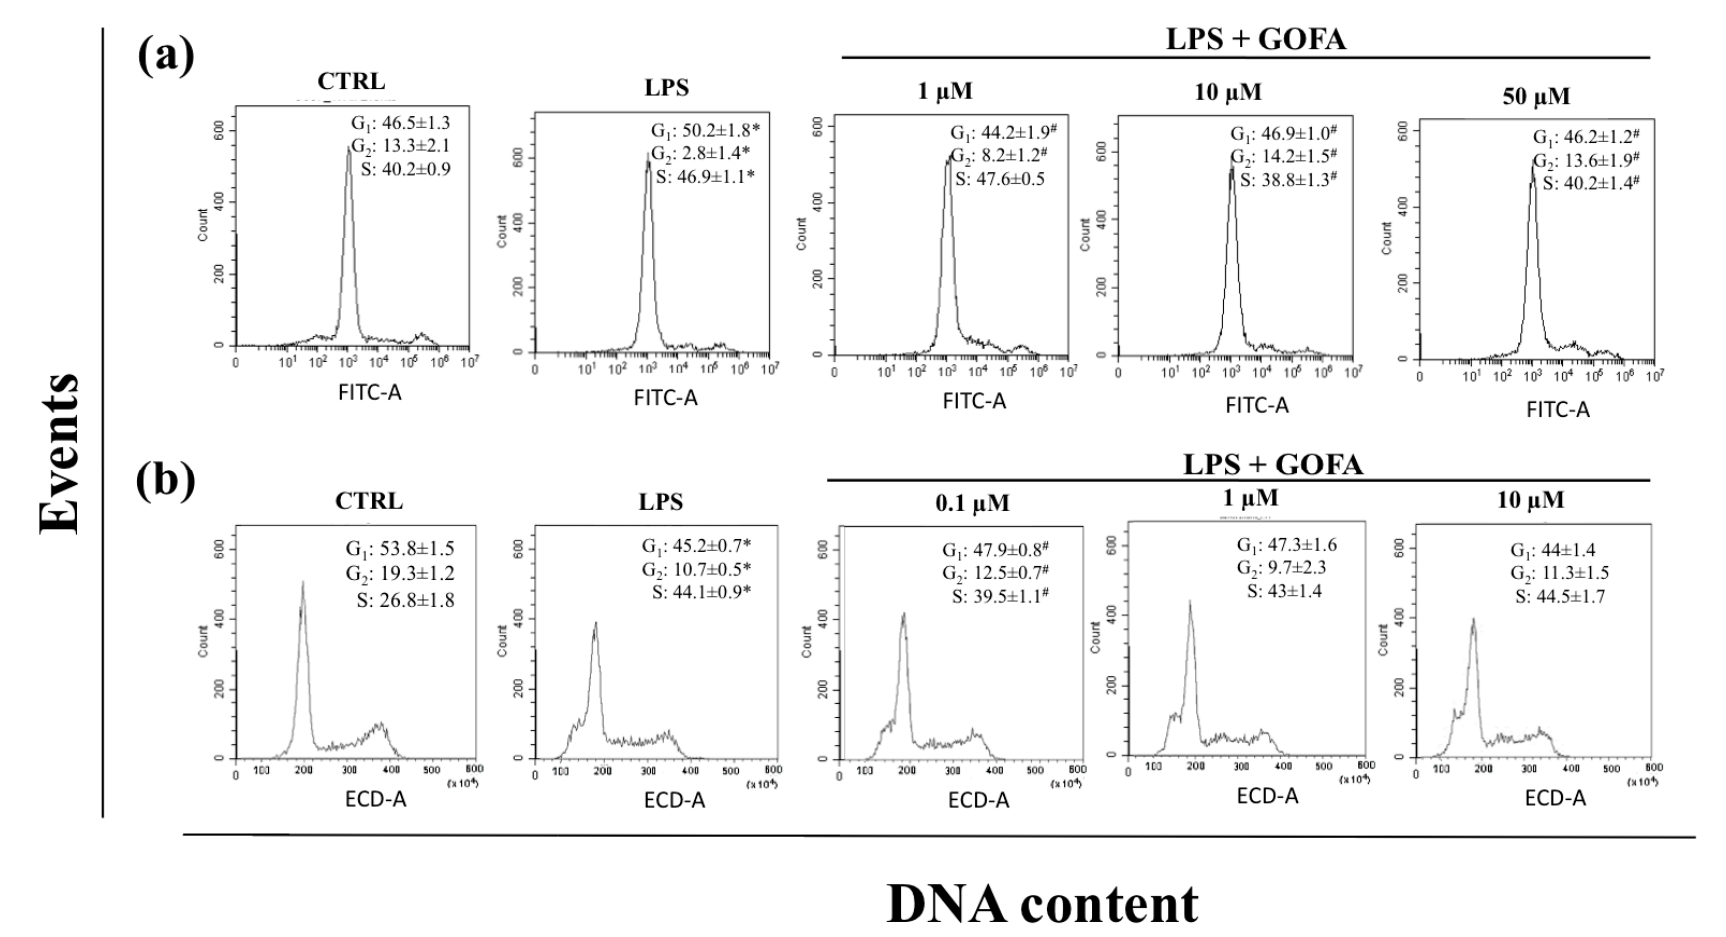
Figure 3. Flow cytometry analysis for cell cycle DNA content in G 0 / G 1 , S, G 2 / M phase after treatment of LPS with and w / o GOFA in U937 and HCT116 cells. ( a ) U937 cells were treated with GOFA and the combination of LPS + GOFA and after 24 h cells were stained with propidium iodide for cell cycle analysis and detected by flow cytometry. Percentage of cells was calculated by using MultiCycle software; ( b ) HCT116 cells were treated with GOFA and the combination of LPS + GOFA and after 24 h treatment, cells were processed as described earlier and cell cycle analysis were performed by Flow cytometry. The figures shown are representative analysis from at least three experiments. * p < 0.05 vs. control cells; # p < 0.05 vs. cells treated with LPS alone.